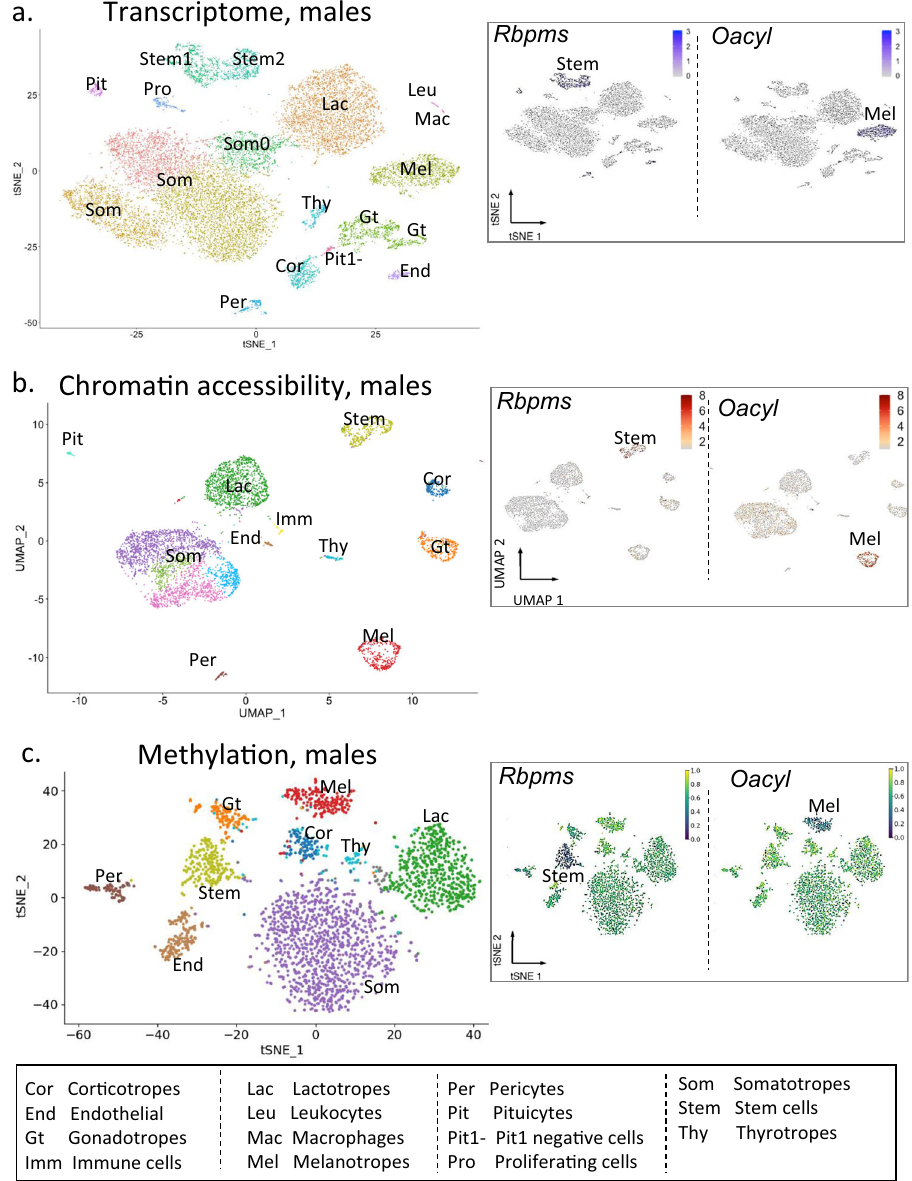
Fig. 2 Identi fi cation of mouse pituitary cell types by merged sn analysis. Each cluster is identi fi ed by a letter code. The code for each cell type is